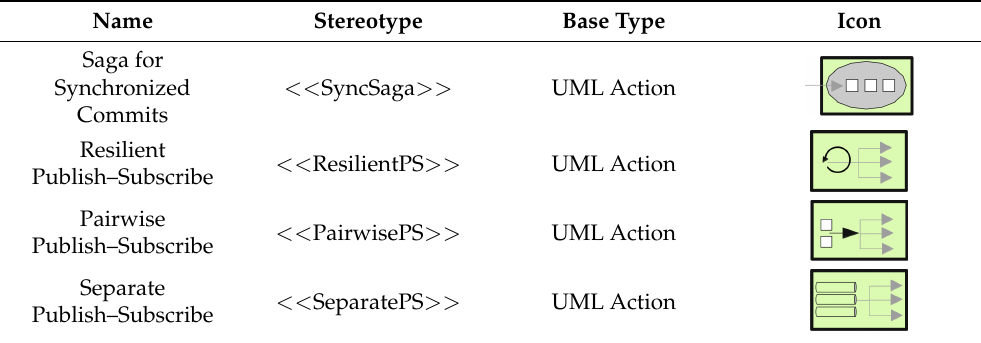
Table 1. New stereotypes for the patterns resulting from research